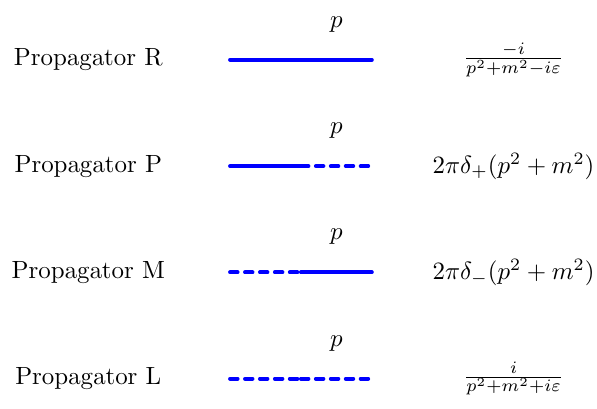
Figure 2. SK propagator for (cid:30)